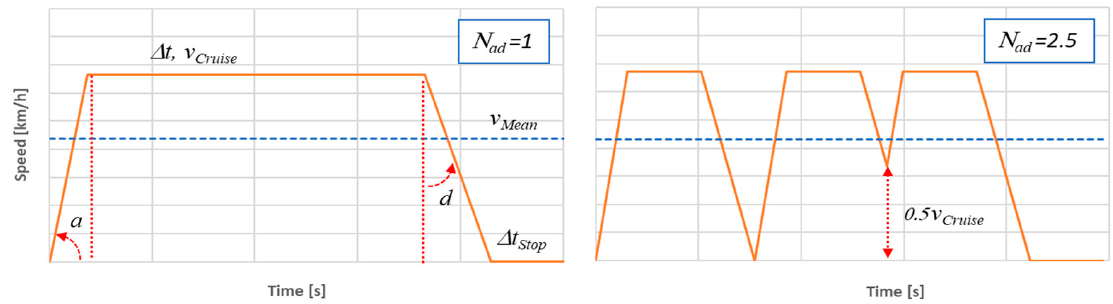
Figure 2. Mission construction procedure.